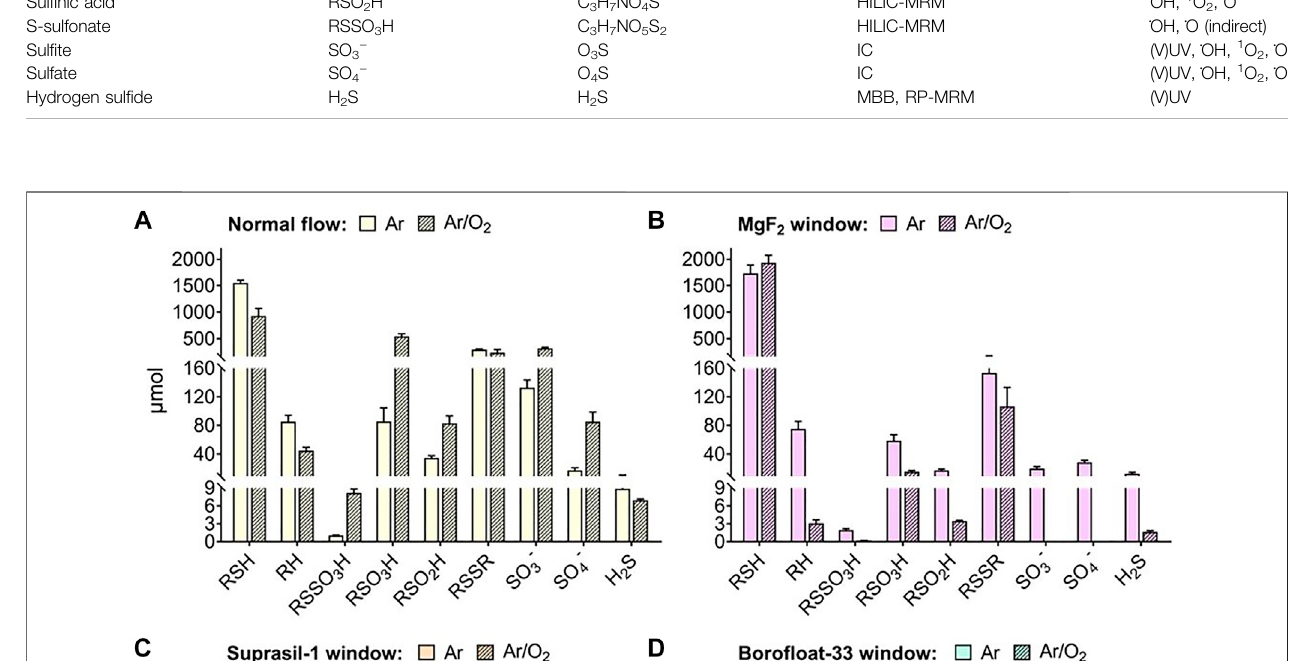
Frontiers in Physics |